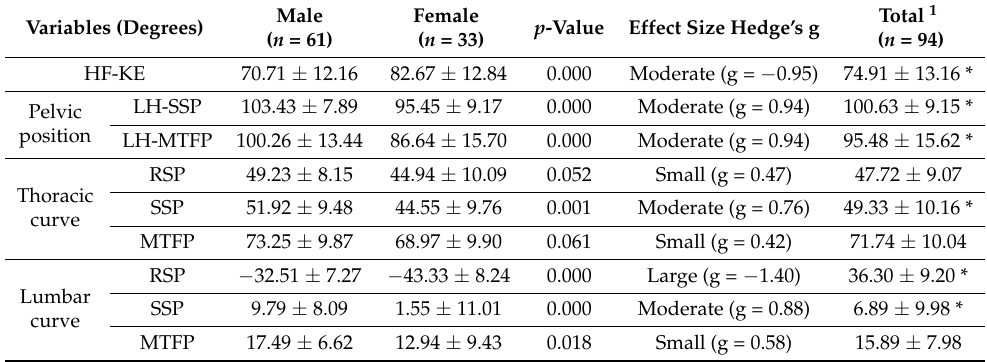
Table 1. Data related to hamstring extensibility, sagittal pelvic position, and sagittal spinal curves in soccer and basketball players according to